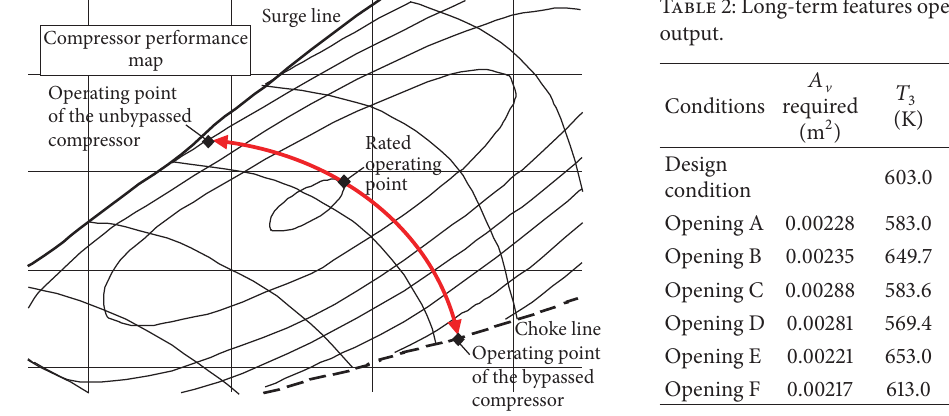
Figure 4: Working points variation on performance map when bypassing single compressor.